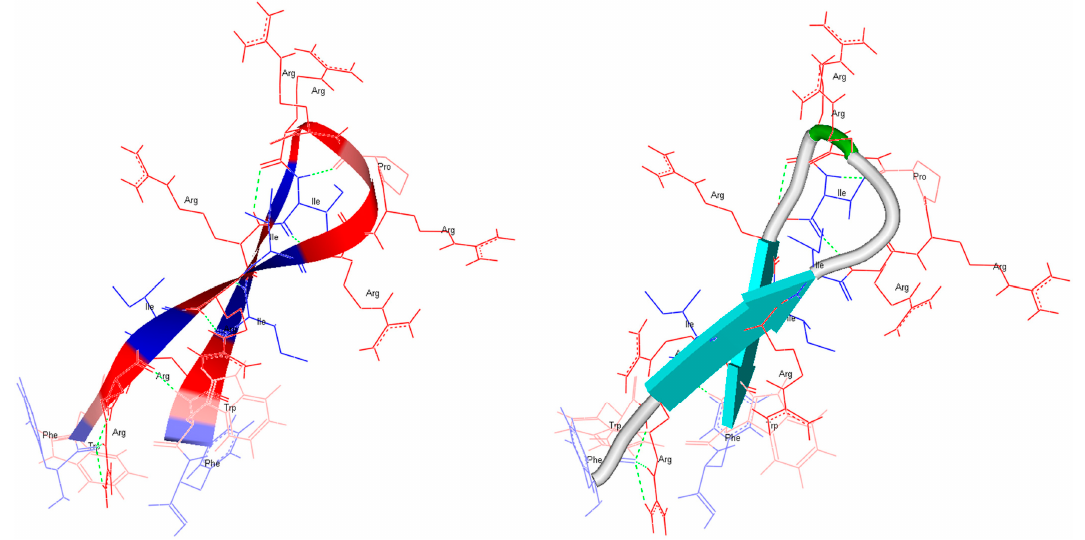
Figure 1. In silico structure prediction of RDP215 with PEP-fold. The amino acids are illustrated in black in the backbone. Left: Color code of positions of amino acids in backbone: Arg (red), Ile, Trp (blue) and Pro (pink). Right: The structure prediction for RDP215 suggests the conformation of a β -strand structure consisting of two β -strands (turquoise) divided by a loop region